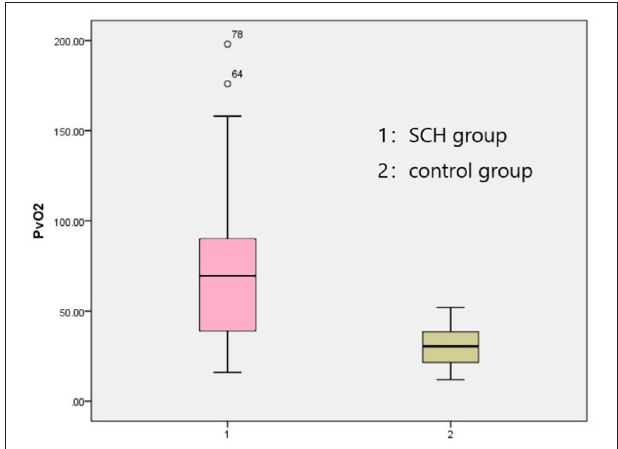
FIGURE 2 | Comparison PvO 2 between two groups.